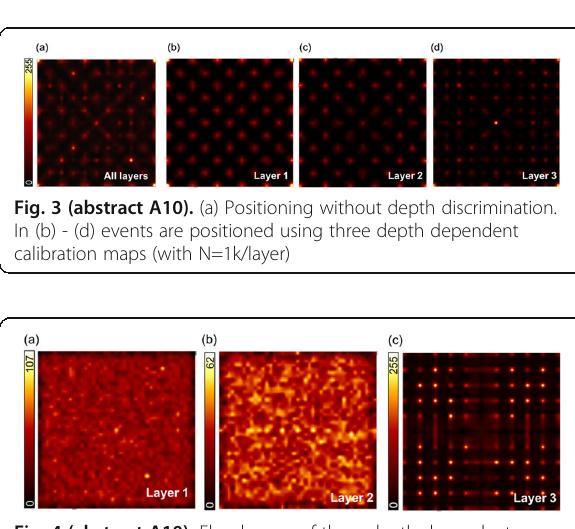
Fig. 4 (abstract A10). Flood maps of three depth dependent calibration maps (with N=1k/layer) with (a) 84651 counts (b) 61641 counts and (c) 53199 counts.The number of bins is